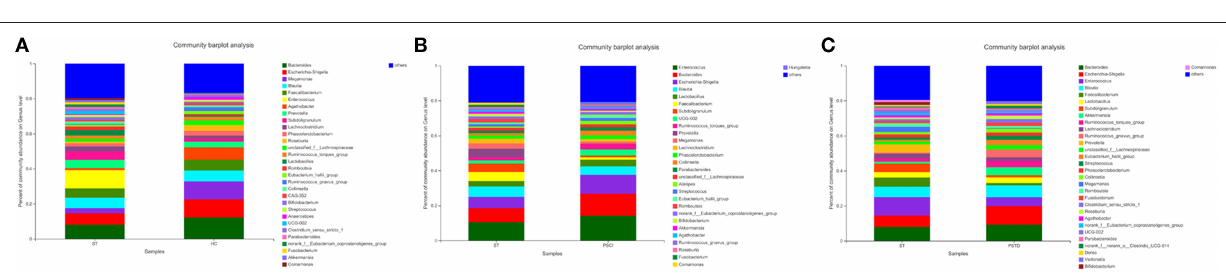
( Figure 5B ). PSTD patients had a significantly higher proportion of Bacteroides and Escherichia-Shigella and a lower content of Enterococcus and Faecalibacterium. By Wilcoxon rank-sum test, there was a significant increase in both the Faecalibacterium ( P < 0.05) and Subdoligranulum ( P < 0.05) genus in the PSTD patients compared with the ST patients ( Figure 5C ). From the Circos diagram, we further validated these results ( Figure 6